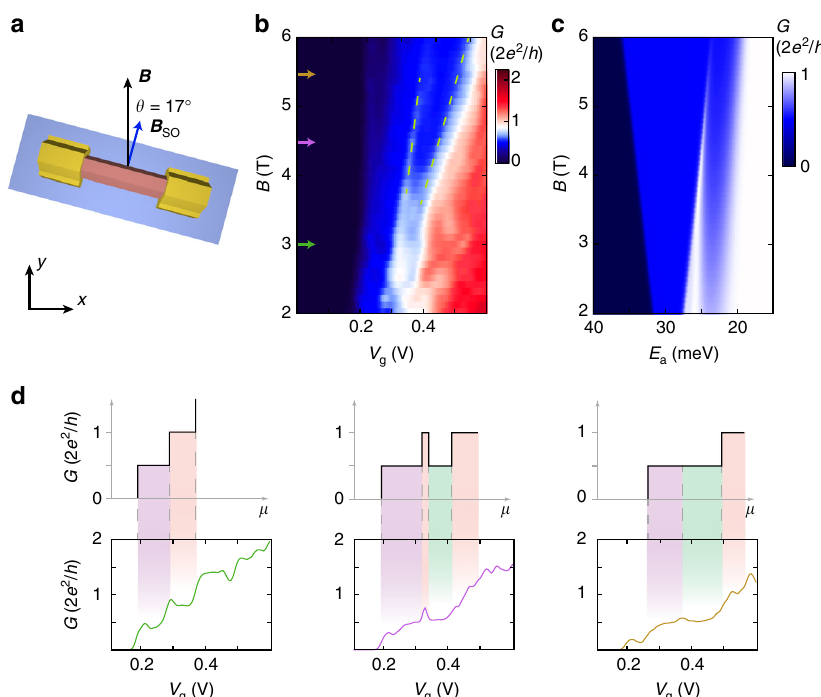
Fig. 2 Magnetic fi eld dependence of the helical gap. a The nanowire lies in the x – y plane at an angle θ = 17° relative to the external magnetic fi eld. b Differential conductance d I /d V at zero source-drain bias as a function of backgate voltage and external magnetic fi eld. At low magnetic fi elds conductance plateaus at multiples of 0.5 · G 0 are visible. Above B = 3 T, a re-entrant conductance feature at 0.5 · G 0 appears in the 1 · G 0 plateau. The feature evolves linearly with Zeeman energy indicated by dashed green lines. c Numerical simulations of the differential conductance as a function of the potential E a and external magnetic fi eld for L = 325 nm, θ = 17° and l SO = 20 nm (Supplementary Note 1 and Supplementary Fig. 1 for a more detailed description of the model). In the numerical simulations, the conductance plateaus have a different slope compared to the experimental data as the calculations neglect screening by charges in the wire. d ( Top ) Sketch of the expected conductance together with the color scheme explained in Fig. 1 and ( bottom ) line traces of the conductance map in b taken at B = 3 T ( green ), B = 4.5 T ( pink ) and B = 5.5 T ( brown ). As the helical gap is independent of disorder or interference effects, these and other anomalous conductance features average out in a 2D colorplot improving the visibility of the helical gap in b compared to